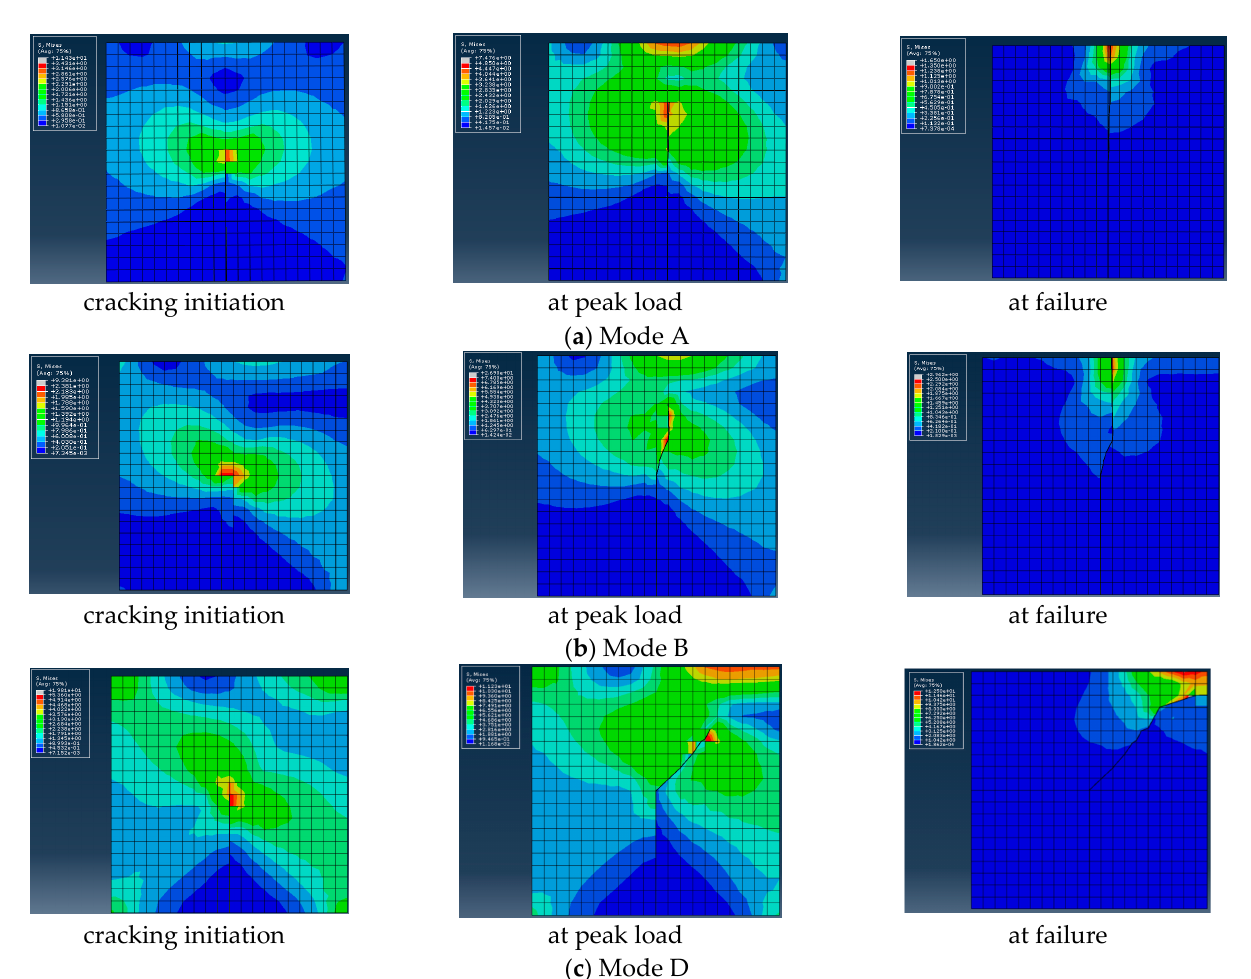
Figure 8. The stress distributions at different stages of loading for three levels of mixed-mode cracking.